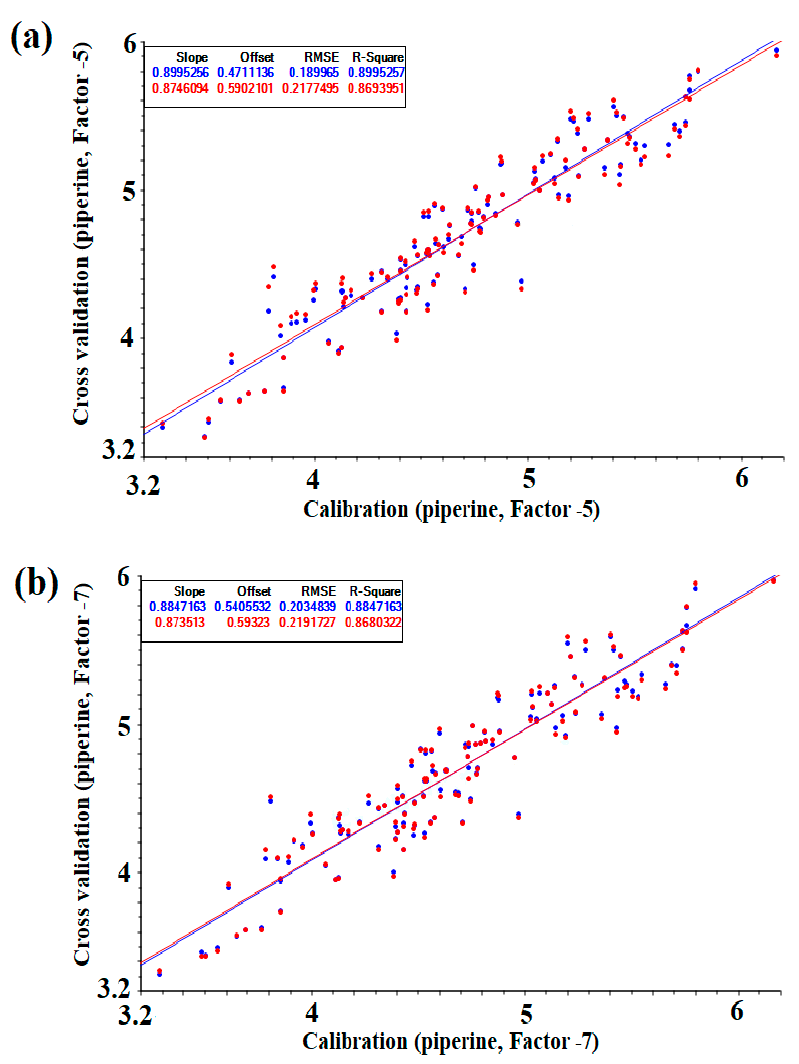
Figure 3. Correlations plot of calibration and cross-validation values versus NIR predicted by the optimized PLS and PC model (g / 100): ( a ) PLS regression, ( b ) PC regression.